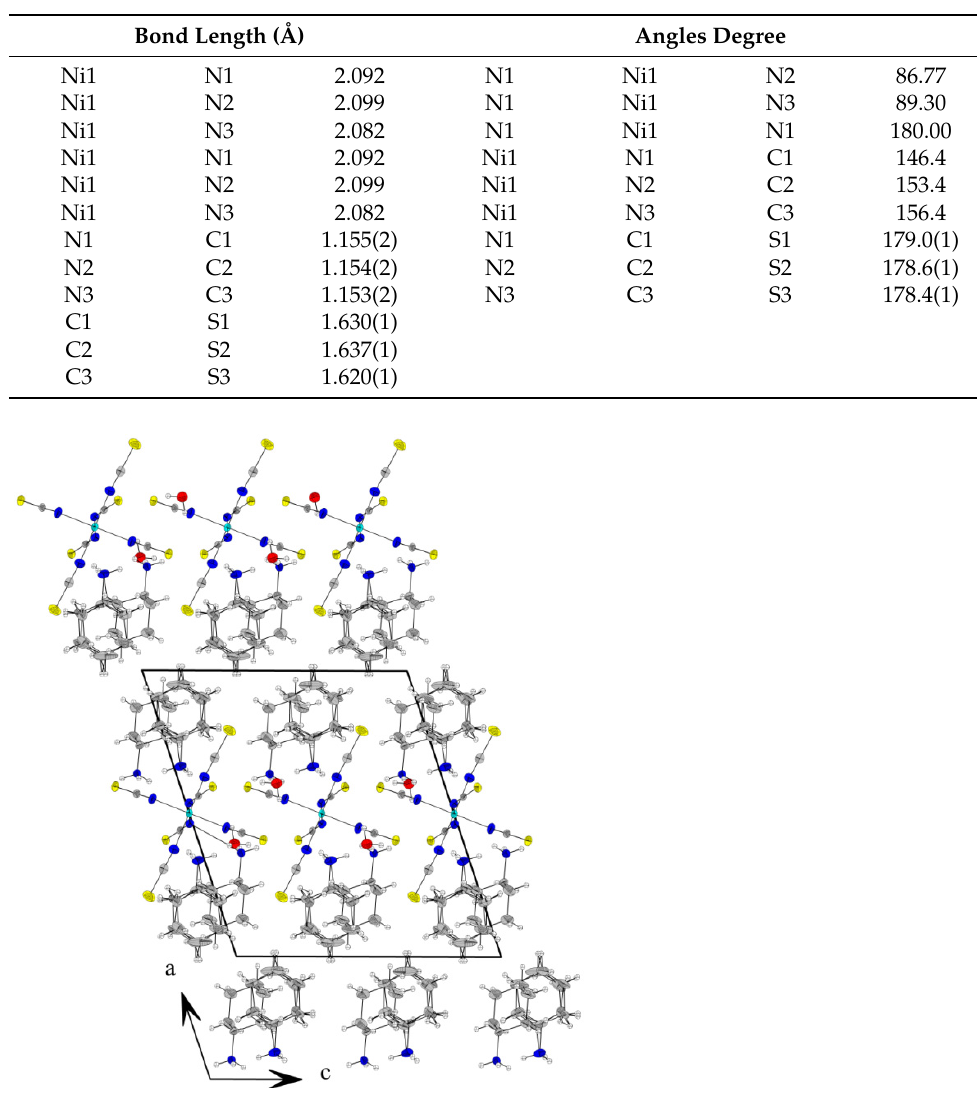
Table 3. Selected angles and bond length of (C 6 H 11 NH 3 ) 4 [Ni(NCS) 6 ] · 2H 2 O.